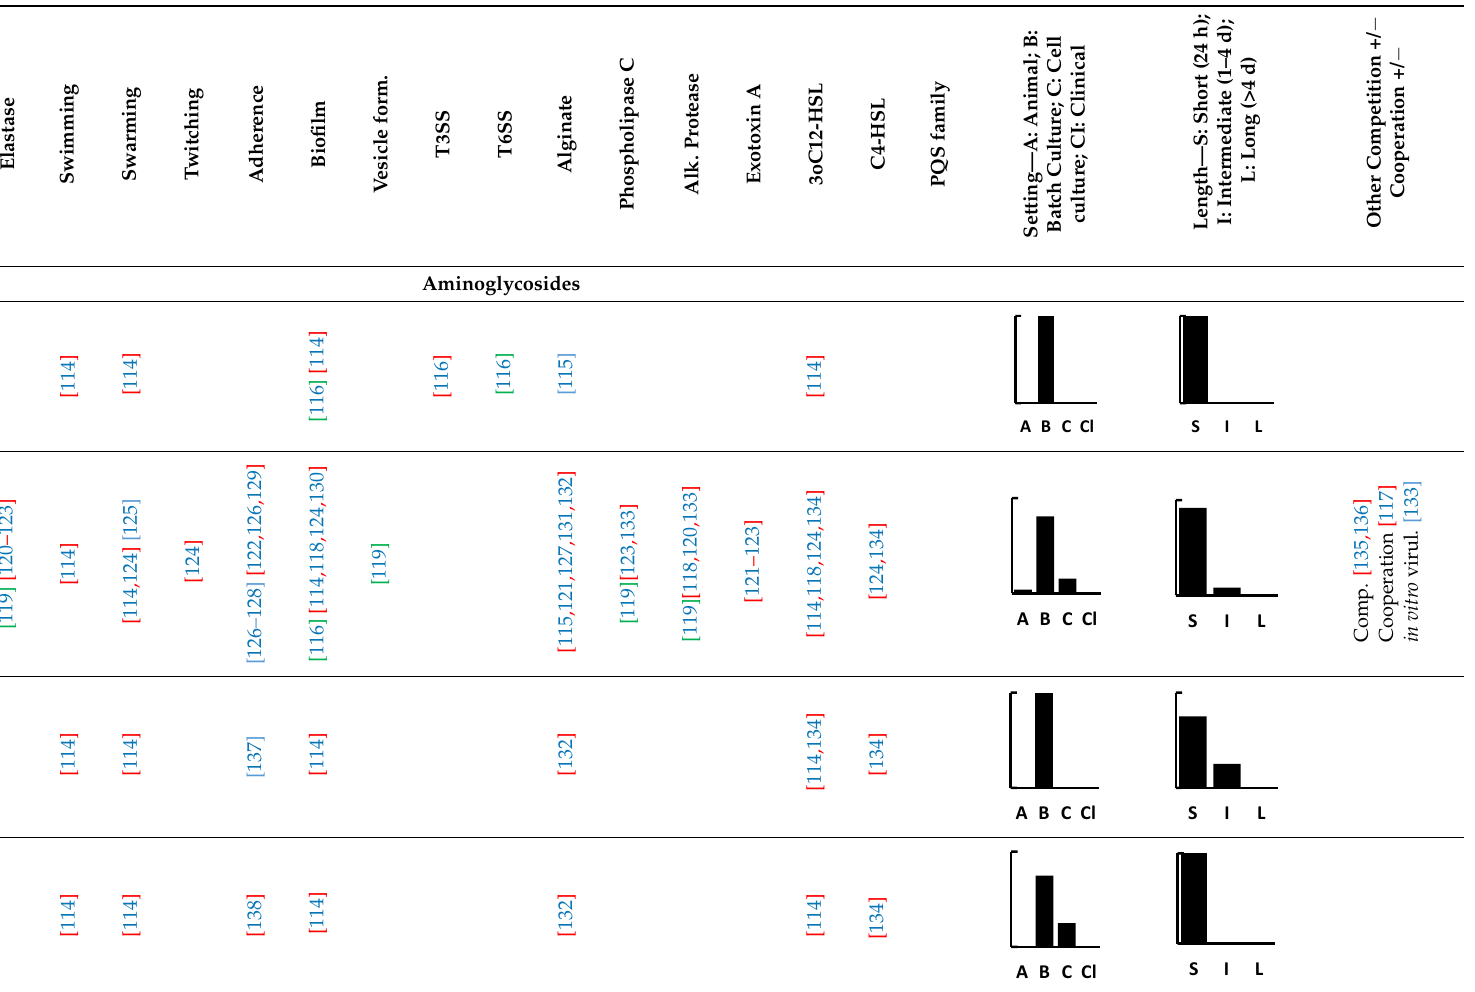
Table 1. Summary of the impact of sub-MIC antibiotic exposure on P. aeruginosa virulence factor production. The colour of the reference indicates the direction of change. Red indicates decreased expression/production, green indicates increased expression/production and blue indicates unchanged or bi-directional and/or concentration-dependent expression/production of virulence factors. The bar charts are normalised to 100% of all studies identified for the antibiotic.